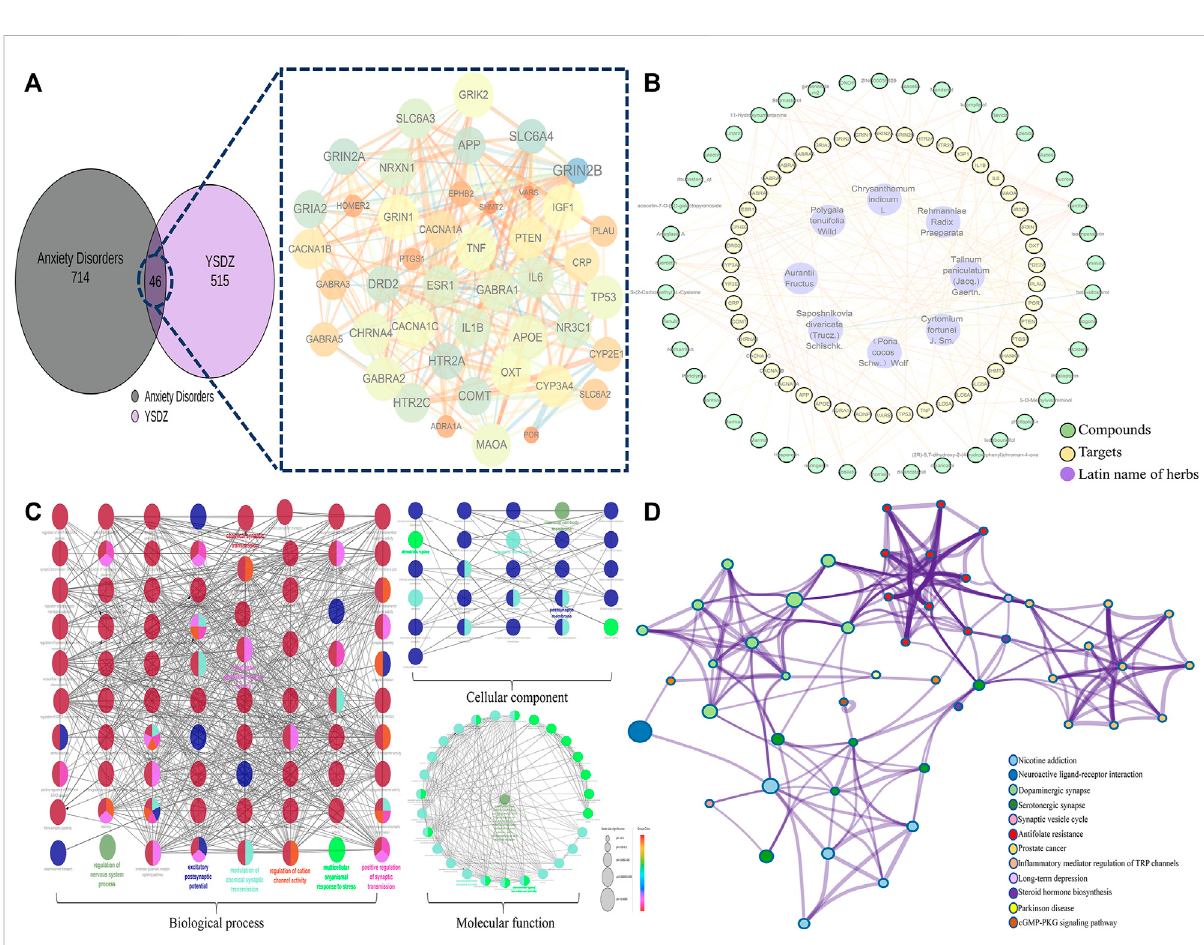
FIGURE 6 Comprehensive analysis of potential targets; (A) Potential target screening; (B) Compounds-Targets-Latin name of herbs network. (C) GO enrichment analysis; (D) KEGG enrichment